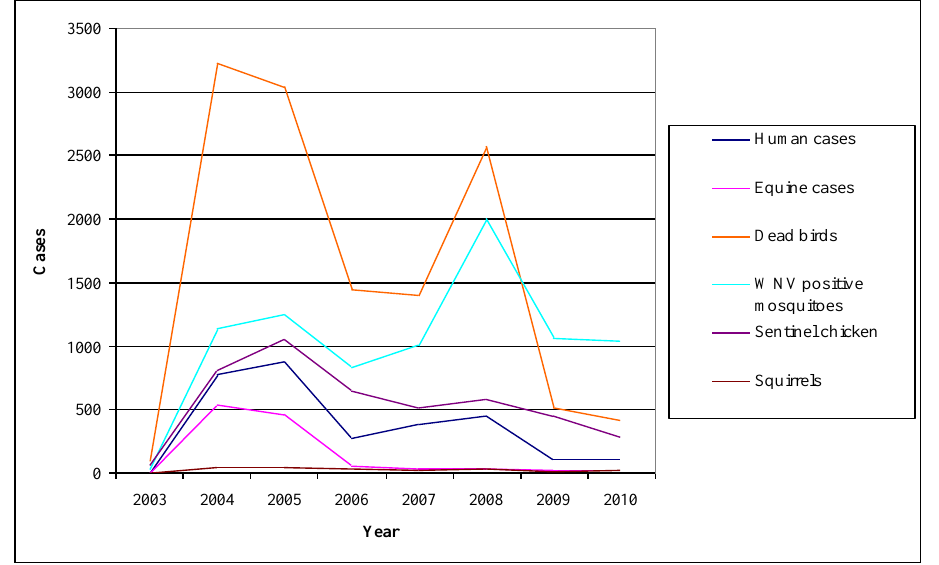
Figure 9. Surveillance system results fluctuation in California, 2003–2010 (data available on: http://www.westnile.ca.gov/ [64]).